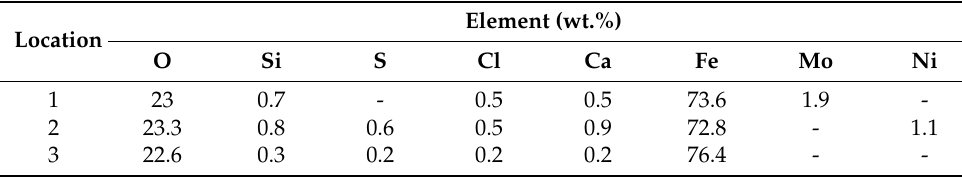
Figure 11. Cross-section 3 cm from the outlet end of tested carbon-steel sample 9 at the end of the last reactor (condenser). Table 11. Elemental analysis from locations in Figure 11.